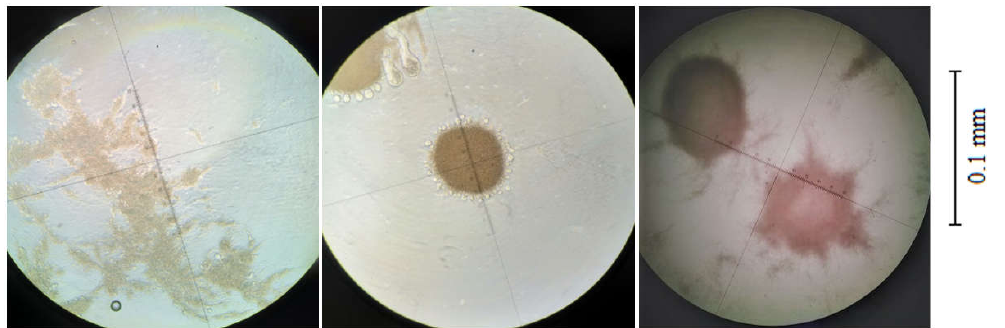
Figure 3. Morphology of M. antarcticus cells before ( left ) and after 30 min of exposure to 5% NaCl ( middle ). Results after a further exposure to the culture exposed to NaCl to 50 mM EDTA for 30 min ( right ) .